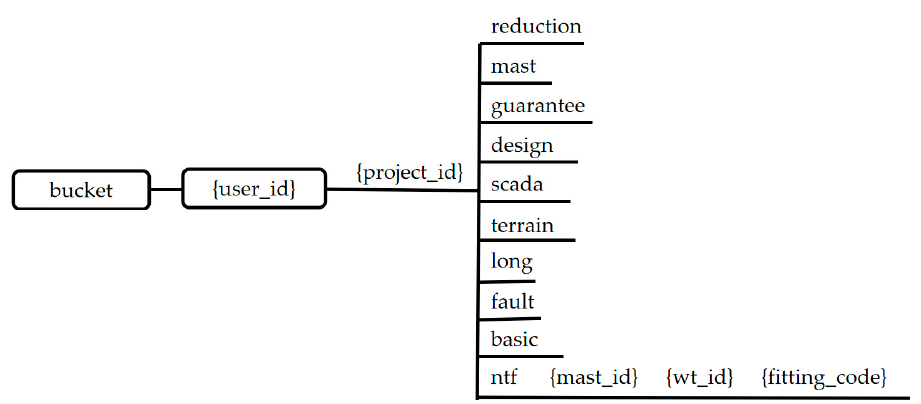
Figure 3. S3 Storage Structure.